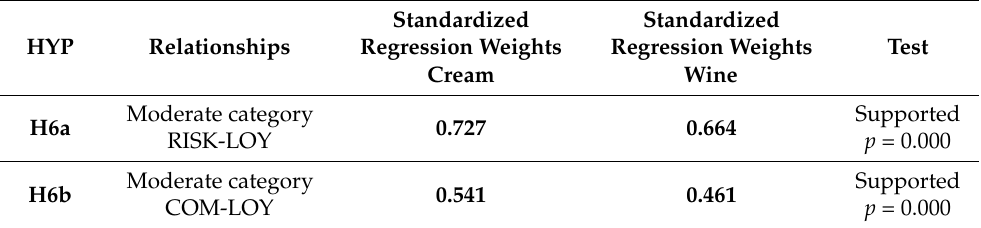
Table 11. Moderation mediation